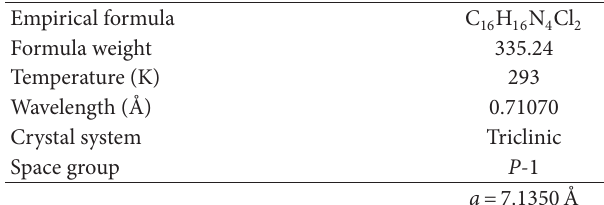
F 1: Chemical diagram of the title compound.